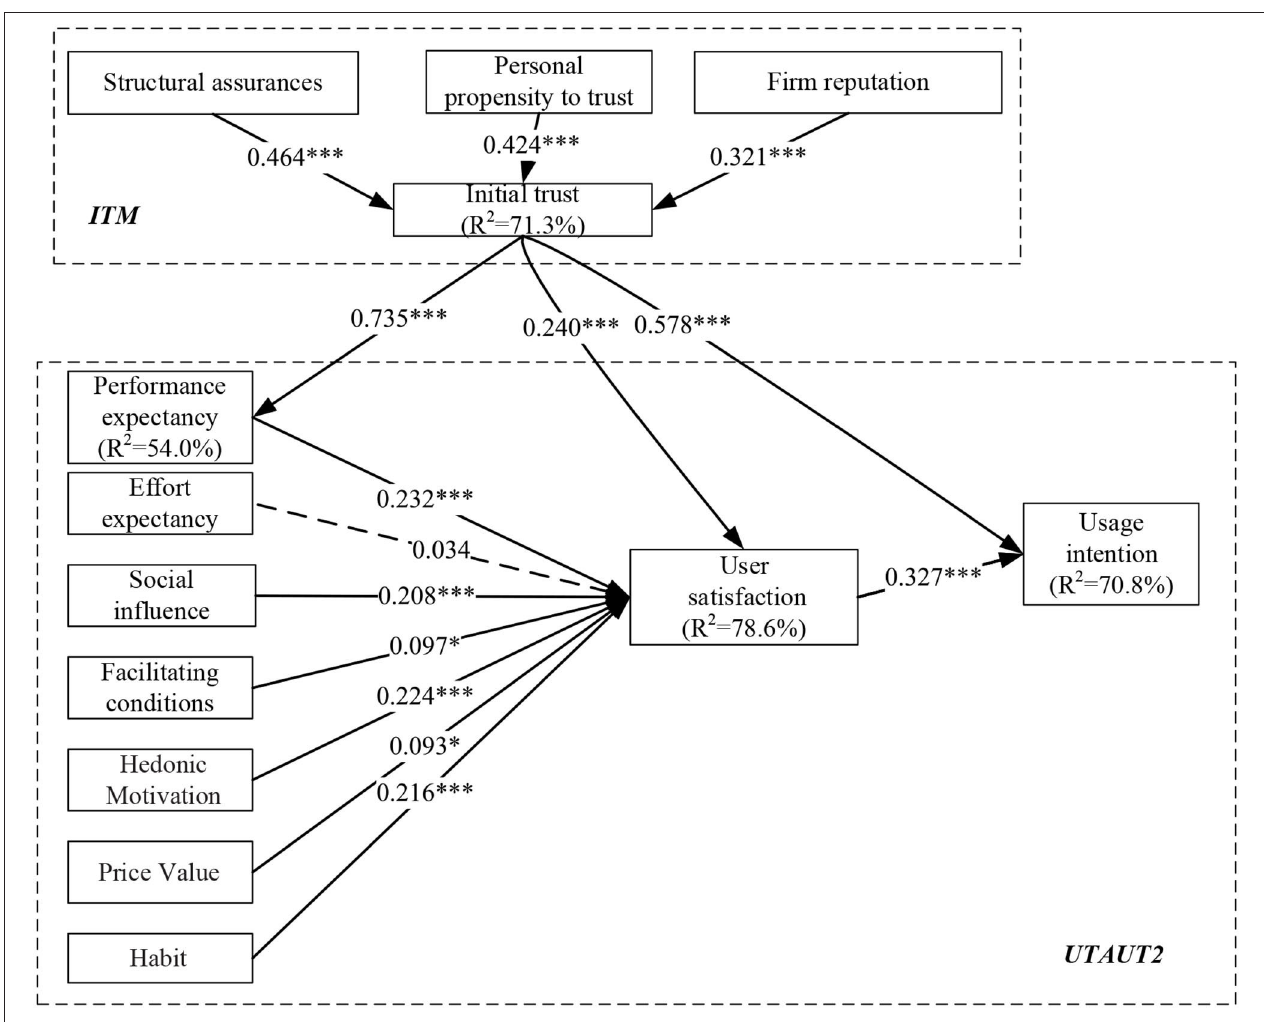
FIGURE 2 | Path analysis of the model (China users). * p < 0.05; ** p < 0.01; *** p < 0.001; ns,